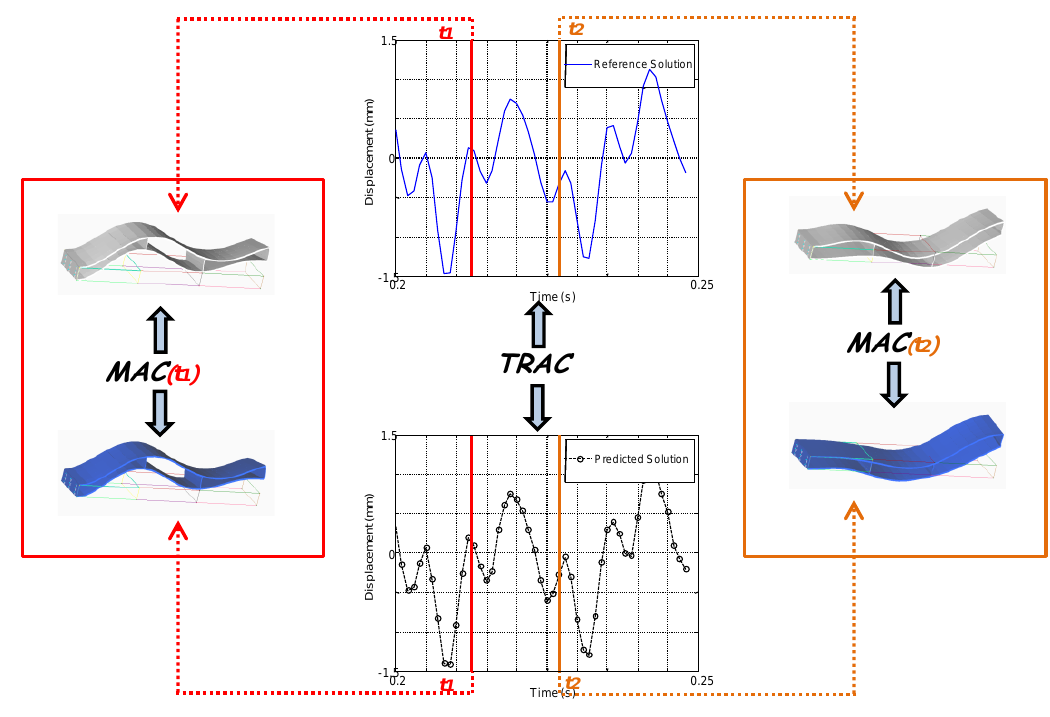
Fig. B-1. Schematic showing MAC and